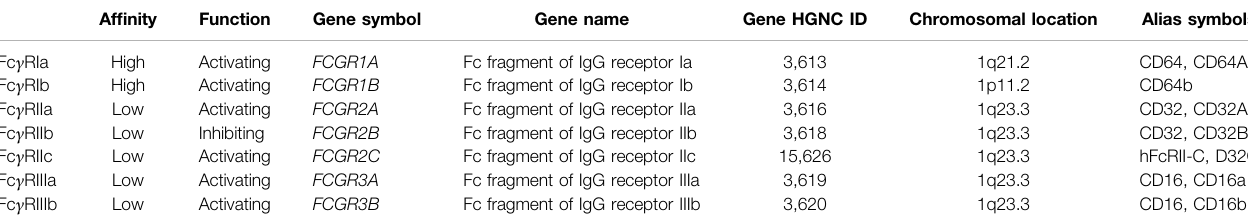
TABLE 1 | Characteristics of the Fc γ Rs. Data extracted from the HGNC database (https://www.genenames.org/). Af fi nity